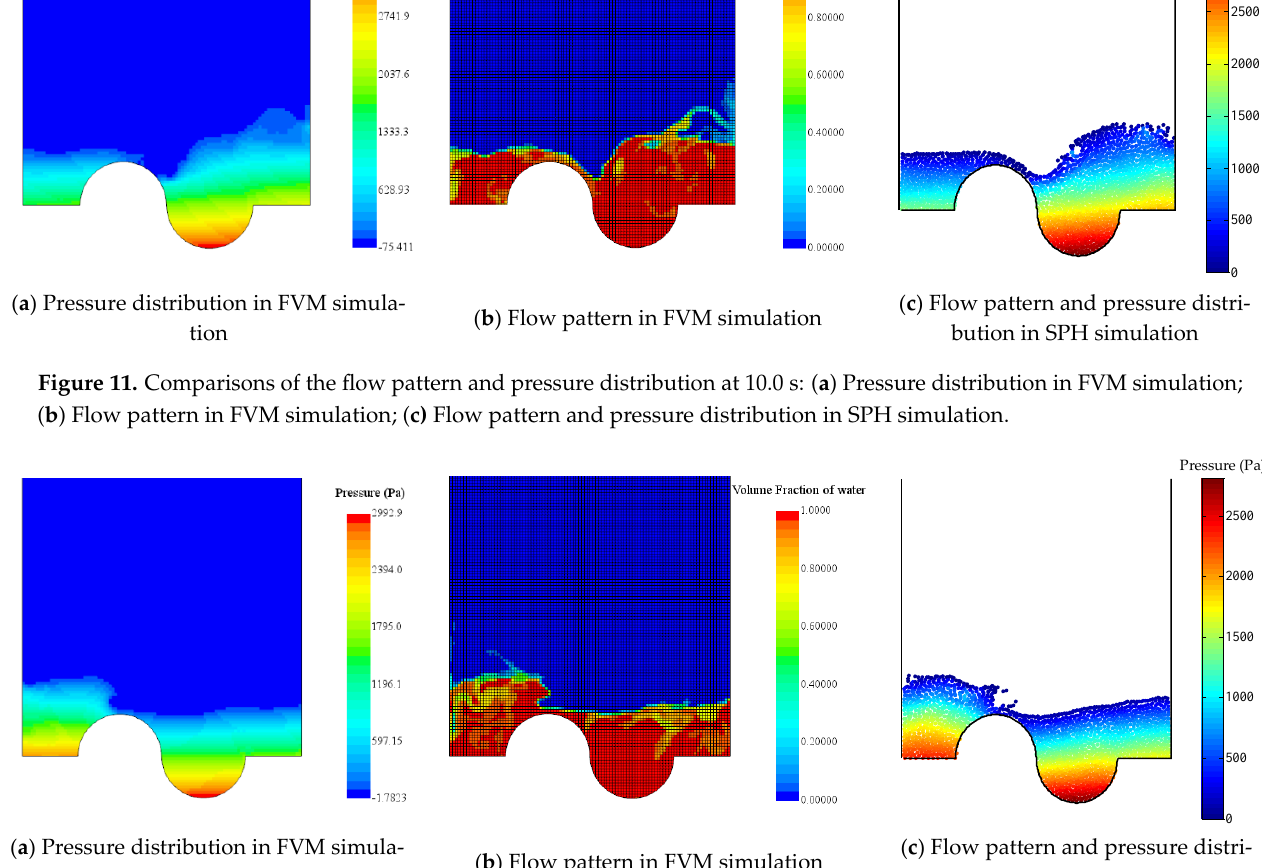
Figure 12. Comparisons of the flow pattern and pressure distribution at 19.0 s: ( a ) Pressure distribution in FVM simulation; ( b ) Flow pattern in FVM simulation; ( c ) Flow pattern and pressure distribution in SPH simulation.